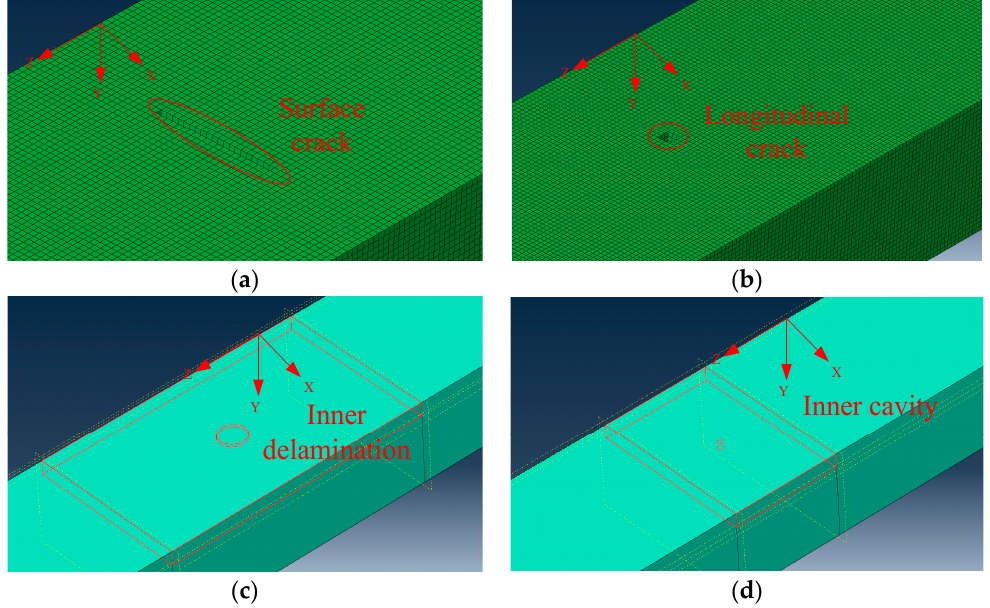
Figure 6. Typical Damage Models of Stator Insulation. ( a )Surface crack; ( b ) Longitudinal crack; ( c ) Inner delamination; ( d ) Inner cavity.